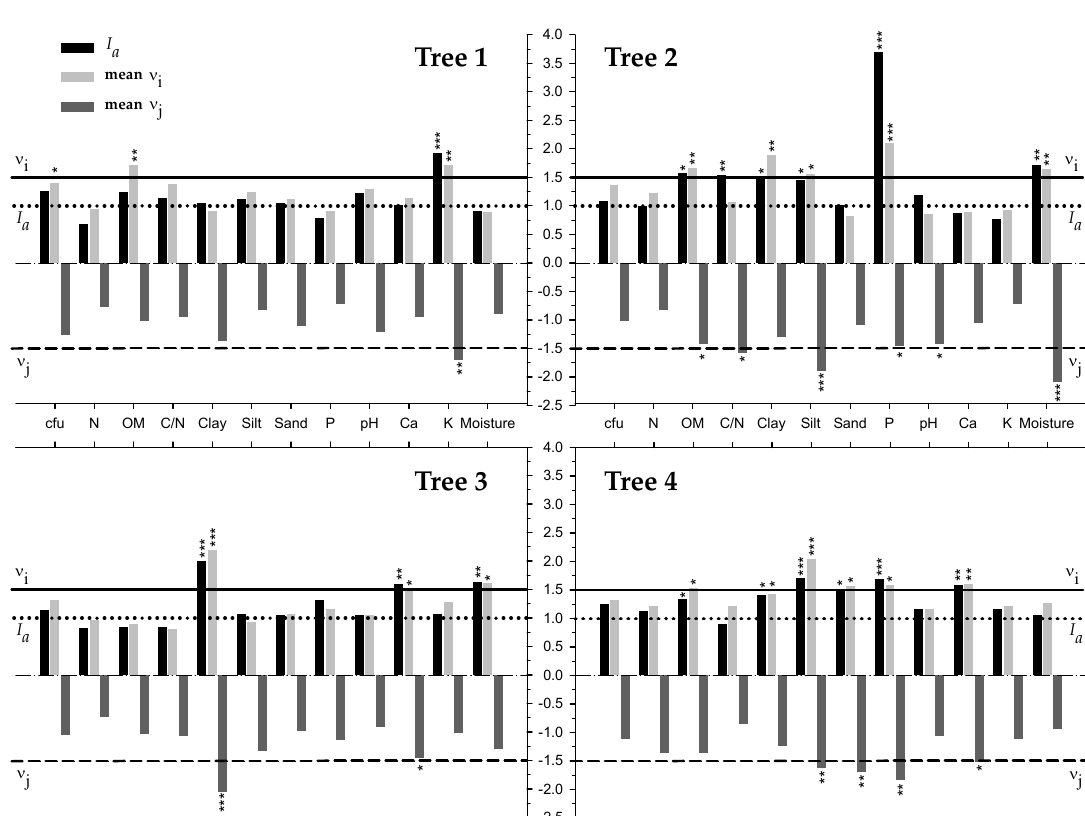
Figure 2. Aggregation indices ( I a ) and clustering indices ( ν ) for the study of 12 variables in the four sampled oaks. The horizontal dotted line I a = 1 indicates the limit of the type of distribution pattern of the variable ( I a > 1 aggregated, I a < 1 regular and I a = 1 random). The horizontal continuous line (mean ν i ≥ 1.5) indicates the limit for which the index ν is grouped into patches, i.e., higher values of a given variable. The horizontal discontinuous line (mean ν j ≤ − 1.5) indicates the limit for which the index ν is grouped into gaps, i.e., lower values of a given variable. * ‐ P < 0.05; ** ‐ P < 0.01; *** ‐ P < 0.001.